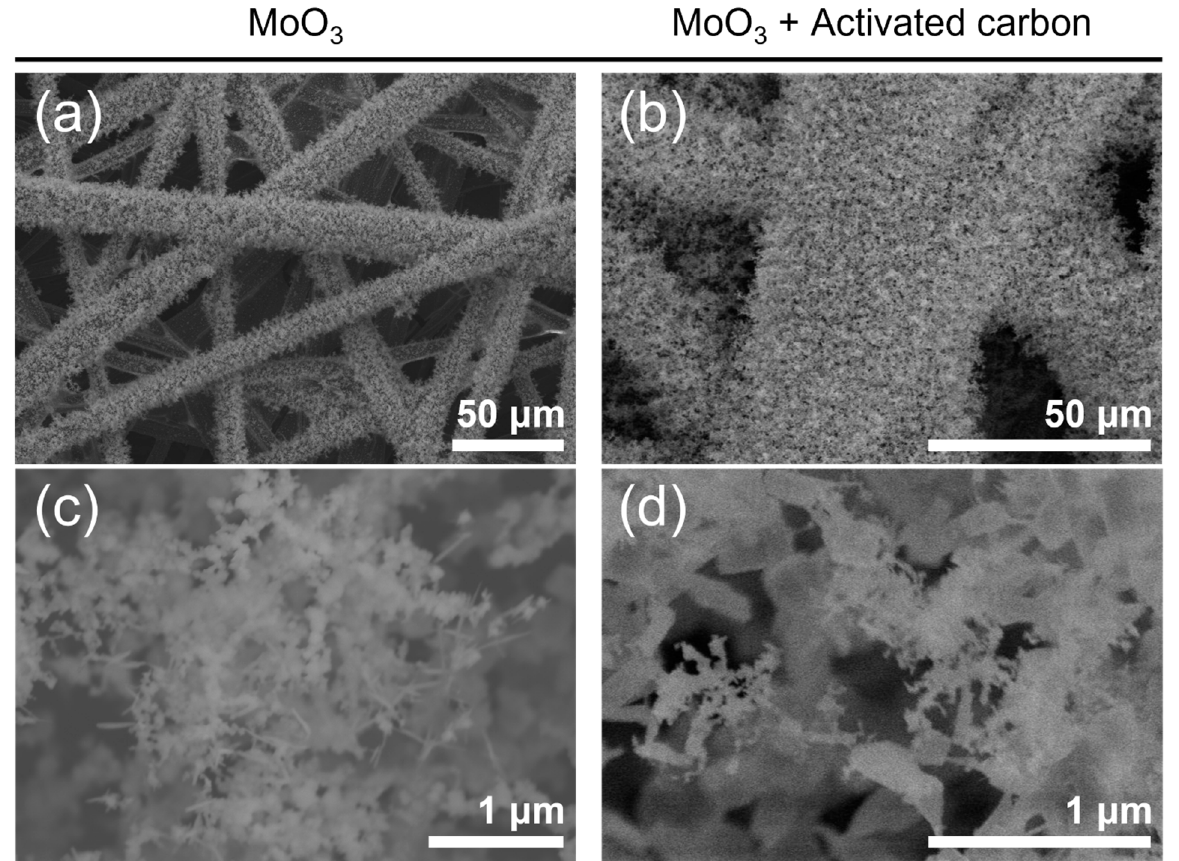
Figure 2. FE-SEM images of the molybdenum oxide nanoparticle aggregates prepared on CFP sub- strates by the CVT method using two different types of precursors: ( a , c ) MoO 3 and ( b , d ) 1:1 (mol/mol) mixture of MoO 3 and activated carbon. ( c , d ) High-magnification FE-SEM images.